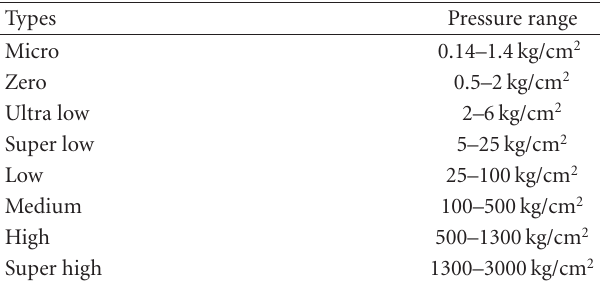
Table 1: Types of pressure sensitive films (Pressurex).